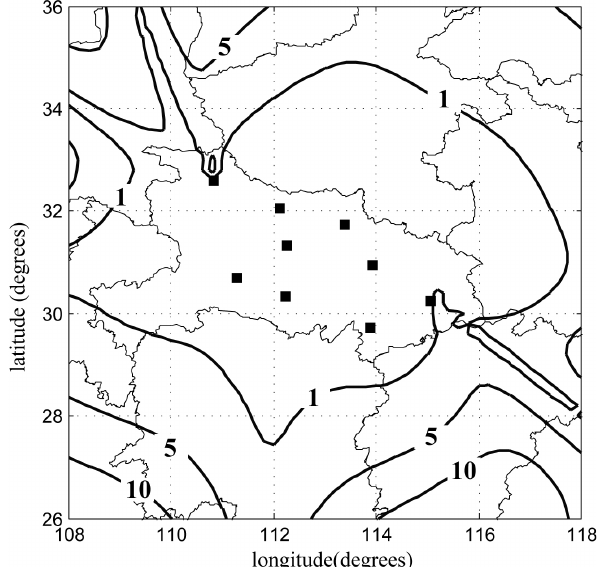
Fig. 9. The spatial distribution of the improved accuracy of the least square positions when the measurements are error free (in meter). The lightning location error is below 10m in the majority area of the investigated region.